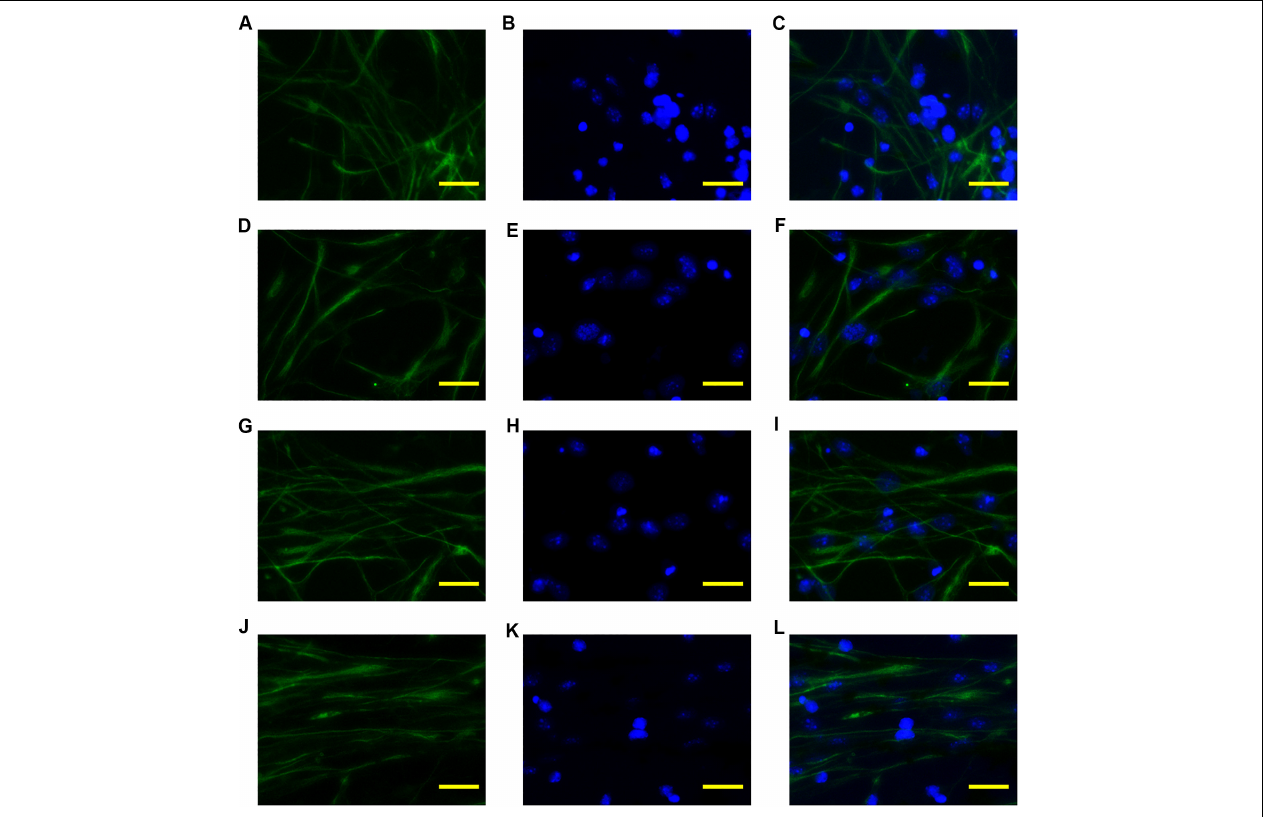
FIGURE 4 | Alignment of neural stem cells. The fluorescent images of Nestin, DAPI, and merged images of the neural stem cells cultured on the PVDF control (A–C) , on the inverse opal substrate (D–F) , on the 3 × stretched substrate (G–I) , and on the 6 × stretched substrate (J–L) . Scale bars are 20 µ